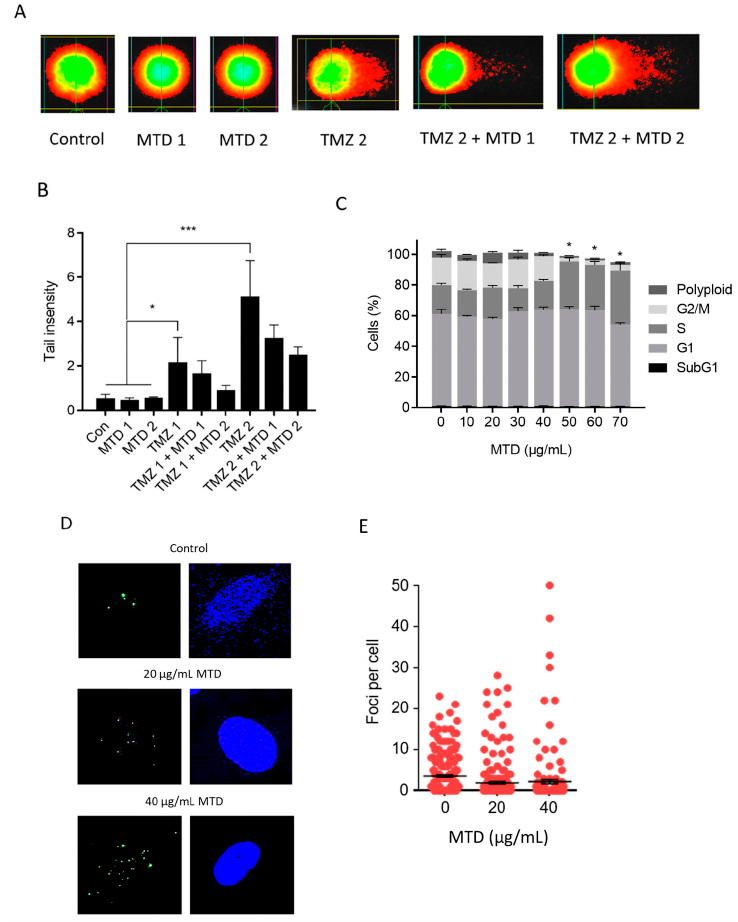
Figure 10. E ff ect of MTD on genotoxicity of TMZ and cell cycle distribution. ( A ) Comet assay, MTD alone (control) and in combination with TMZ, measured by the alkaline comet assay. Representative pictures are shown. ( B ) Quantification: TMZ 1, 100 µ M; TMZ 2, 200 µ M; MTD 1, 10 µ g / mL, MTD 2, 30 µ g / mL. Data represent the mean of three independent experiments ± SEM. * p < 0.05; *** p < 0.001. ( C ) Cell cycle distribution of LN229 cells treated with increasing concentrations of MTD. * indicates significant di ff erence ( p > 0.05) of S and G2 fraction from control. ( D ) Representative pictures of γ H2AX foci and ( E ) foci levels in LN229 cells measured 24 h after addition of MTD to the medium. The di ff erences in the mean foci number between control and MTD are statistically not significant.